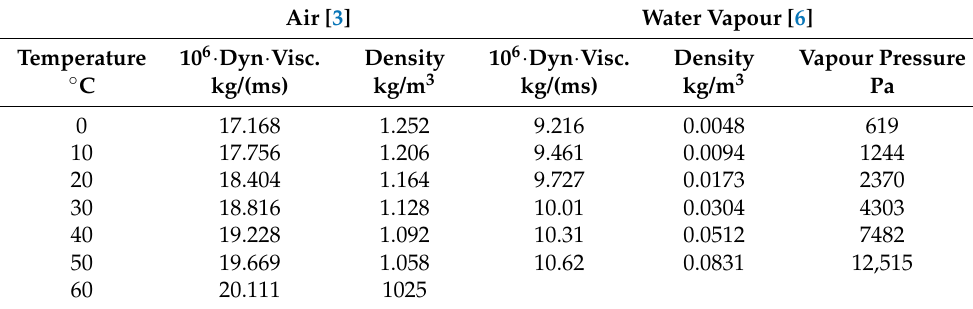
Table 1. Some parameters of air and water